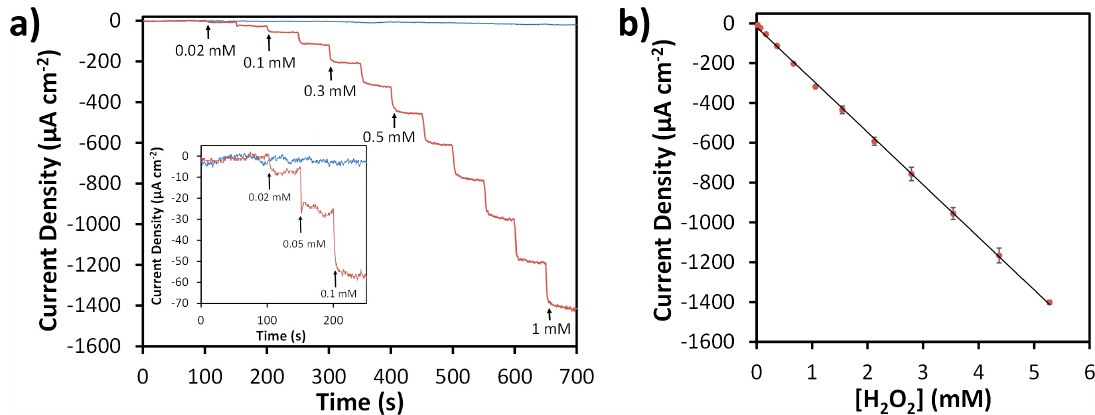
Figure 6. Amperometric detection of H 2 O 2 in 0.05 M phosphate buffer (pH 7.4) at − 0.4 V vs. Ag/AgCl. Representative current-time traces obtained from consecutive injections of H 2 O 2 ( a ) using SPCE (blue) and N-SPCE (red). Arrows and labels indicate spike times and concentrations. Inset shows low concentration injections. Calibration curve ( b ) obtained from average results of four N-SPCEs. Error bars correspond to ±1 standard deviation.